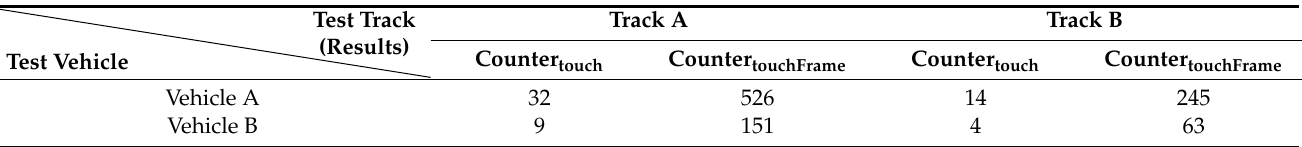
Table 1. Test results of vehicles driving with 35% throttle with different steering mechanisms on different tracks for 10